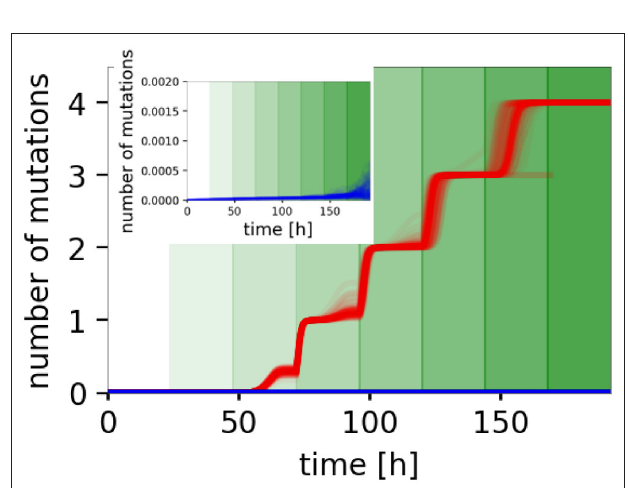
FIGURE 6 | Accumulation of mutations. The average number of mutations per cell in planktonic culture (red) and biofilm (blue) when both phenotypic mechanisms are considered. See Supplementary Material for individual effects. The switch in the shades of green represents times when the antibiotic concentration is doubled. Showing 100 stochastic simulations for each